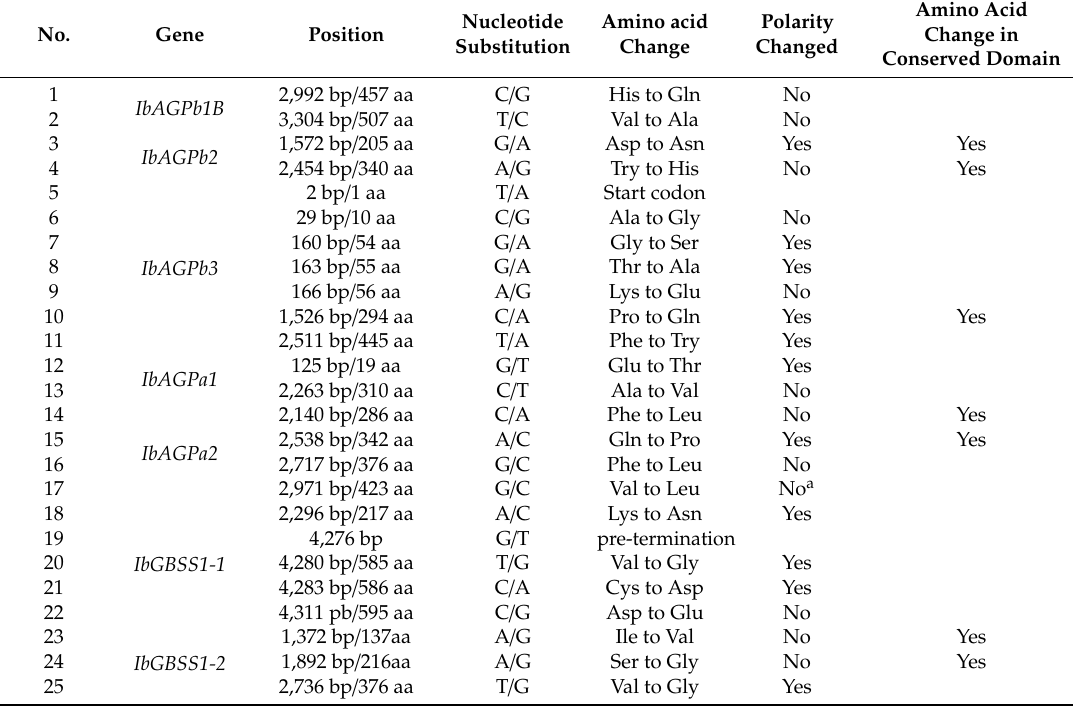
Table 1. Non-synonymous SNPs (nsSNPs) detected in the candidate gene